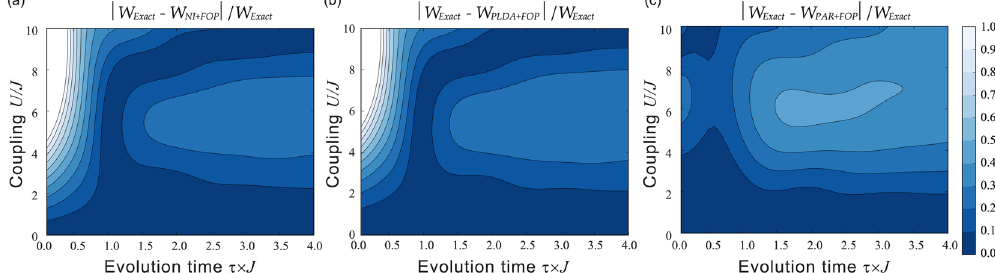
Figure 4. Relative error of the mean extractable work for the first-order correction to the eigenenergies’ protocol. Contour plot of the relative error is shown as function of the dimensionless particle-particle interaction strength U / J and the dimensionless evolution time τ × J . ( a ) Dynamics is generated by standard zero-order perturbation theory. ( b ) Dynamics is generated by KS-based zero-order perturbation theory using the PLDA approximation for the exchange-correlation potential. ( c ) Dynamics is generated by KS-based zero- order perturbation theory using an accurate parametrization for the exact correlation energy E c